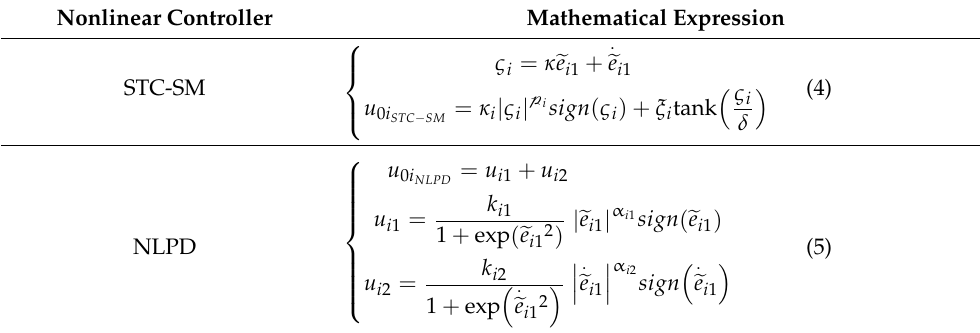
Table 1. Proposed nonlinear controller mathematical expressions. Nonlinear